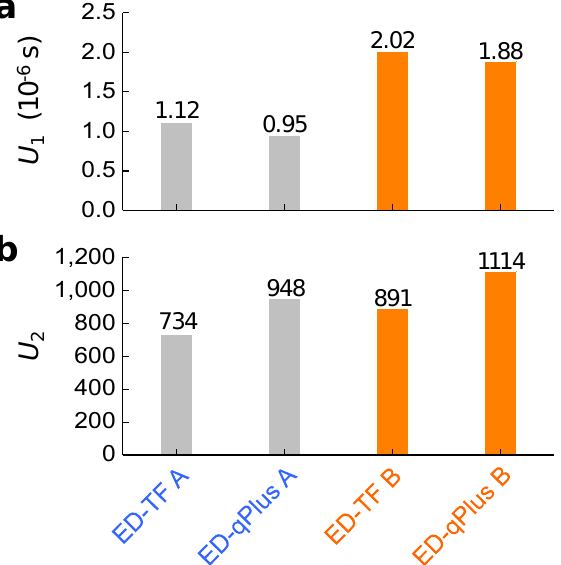
Figure 5. Two constants U 1 ( a , Equation (11)) and U 2 ( b Equation (12)) derived from the electromechanical model (Figure 4) for the electrically driven tuning fork and the qPlus sensor. Although the qPlus and its original bare tuning fork exhibit very different dynamic characteristics (Figure 3), the two constants U 1 and U 2 , made of their combinations, show almost similar values for qPlus and tuning fork, as expected from our model (Figure